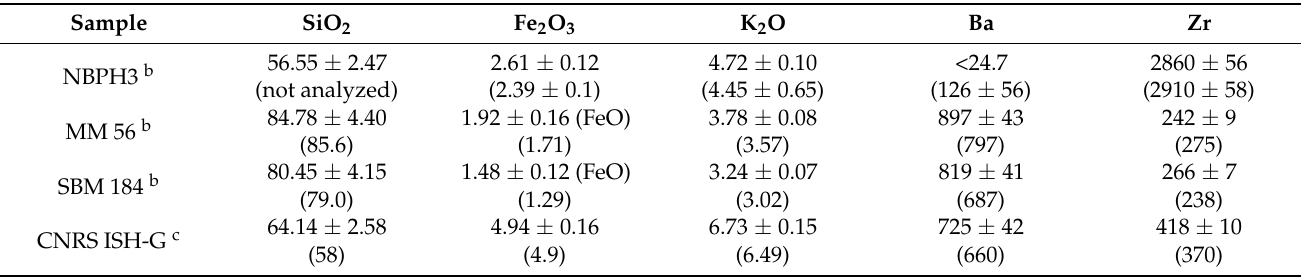
a Combined standard uncertainty (see Table 3 for definition). b NBPH3—phonolite (Sokol Hill, Lusatian Mts., north Bohemia), MM 56— moldavite (Rouchovany, Moravia), SBM 184—moldavite (Pišt í n, south Bohemia). Reference values determined previously in our laboratory by INAA and IPAA with long-time irradiation (Zr) given in parenthesis. c Working values from the certificate given in parenthesis.